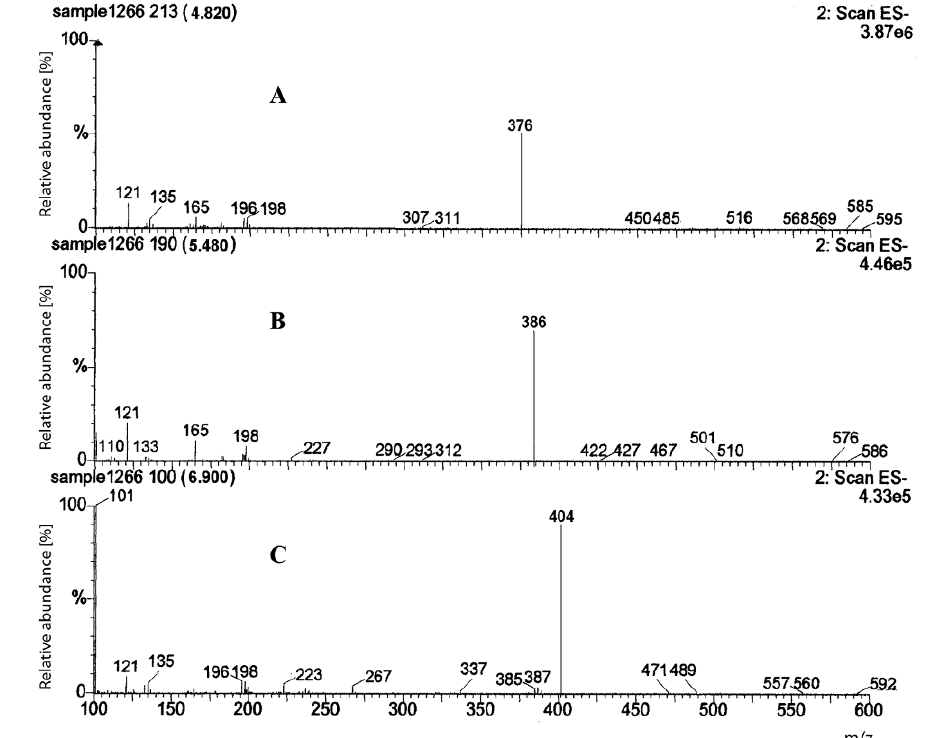
Figure 6. ES- mass spectrum (A) for IMD degradation product I, (B) for IMD degradation product II and (C) for pure